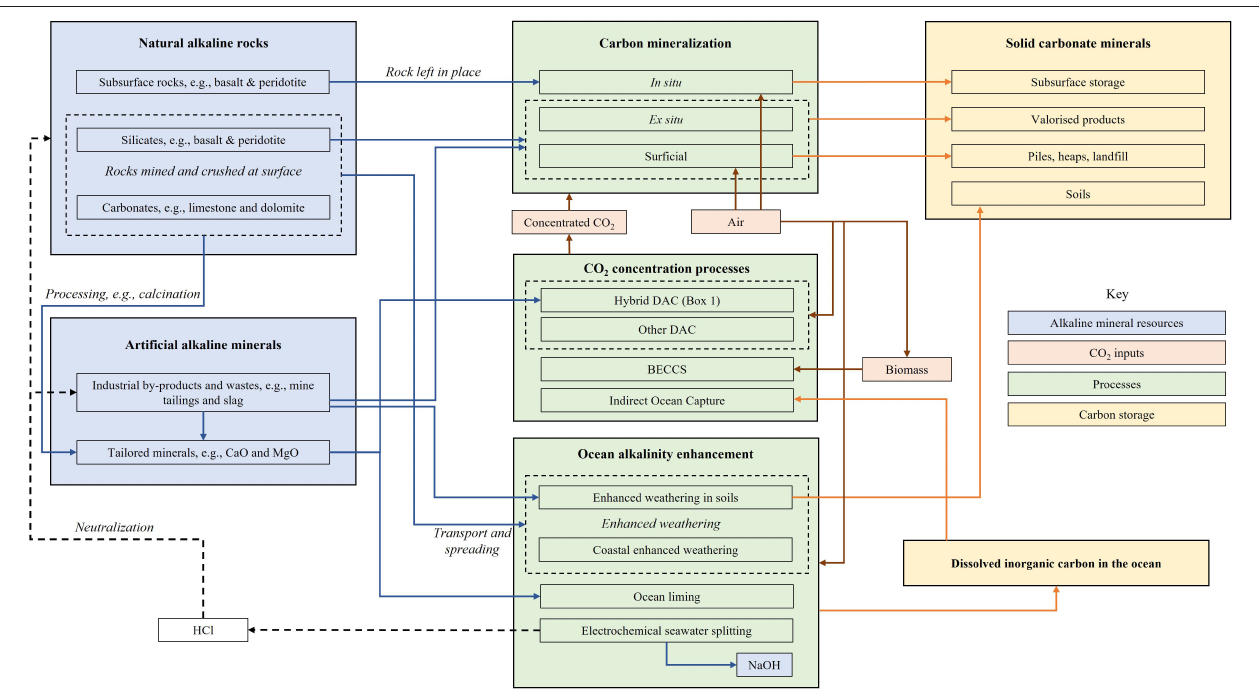
FIGURE 1 | Conceptualizing many of the possibilities for geochemical NETs by combinations of CO 2 and alkaline minerals.